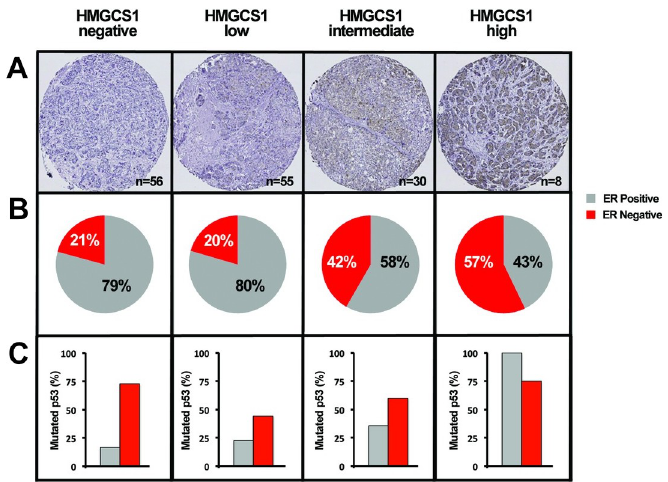
Fig 4. HMGCS1 expression associates with basal tumours in a breast cancer patient cohort. A. HMGCS1 expression in a tissue microarray (TMA) from 149 patients with lymph-node positive breast cancer. B. Comparative pie charts for each HMGCS1 subgroup (negative, low, intermediate and high) showing the frequency of ER α -positive and ER α -negative tumour subtypes present in each. C. Percentage of p53 mutations in ER α -positive and ER α -negative breast cancers for HMGCS1